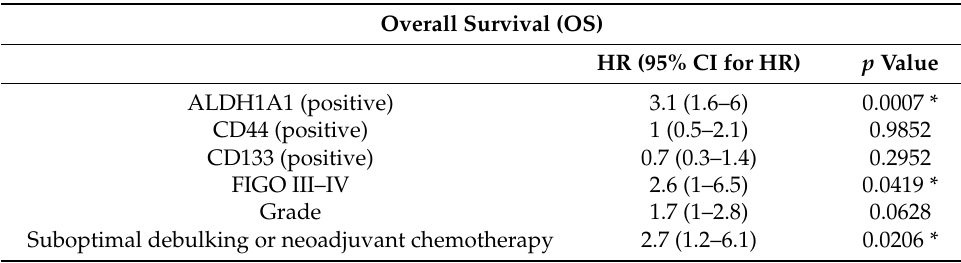
Table 3. Multivariate Cox regression analysis using overall survival as a dependent variable in ovarian cancer